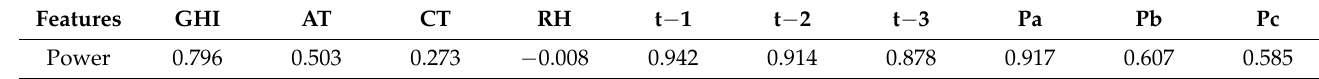
Table 3. Correlation coefficient.